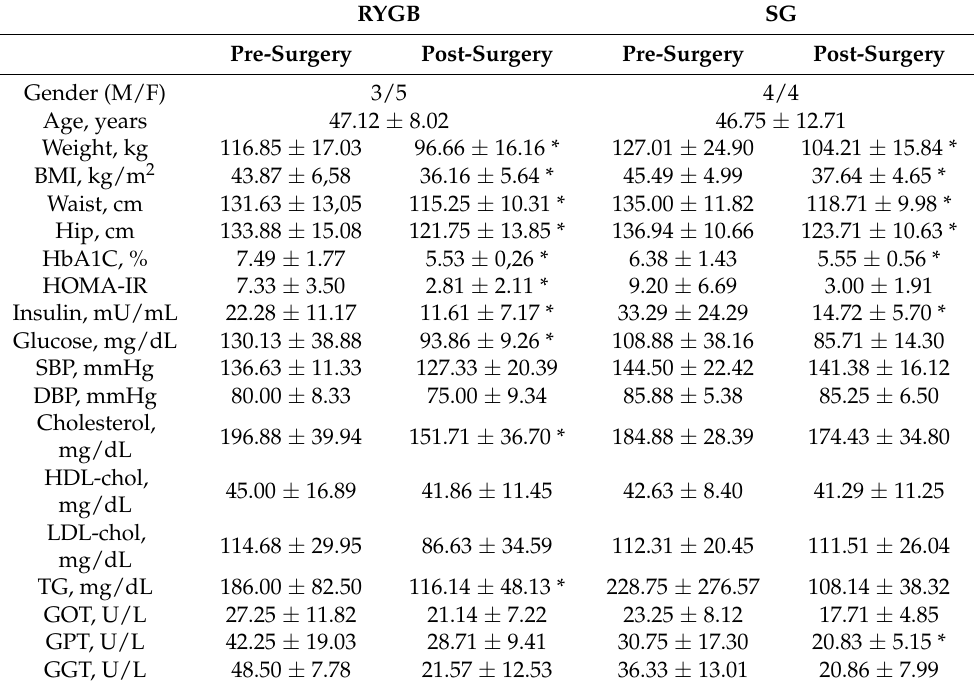
Table 1. Biochemical and clinical characteristics of both study groups at pre-and post-surgery timepoints. RYGB SG Pre-Surgery Post-Surgery Pre-Surgery